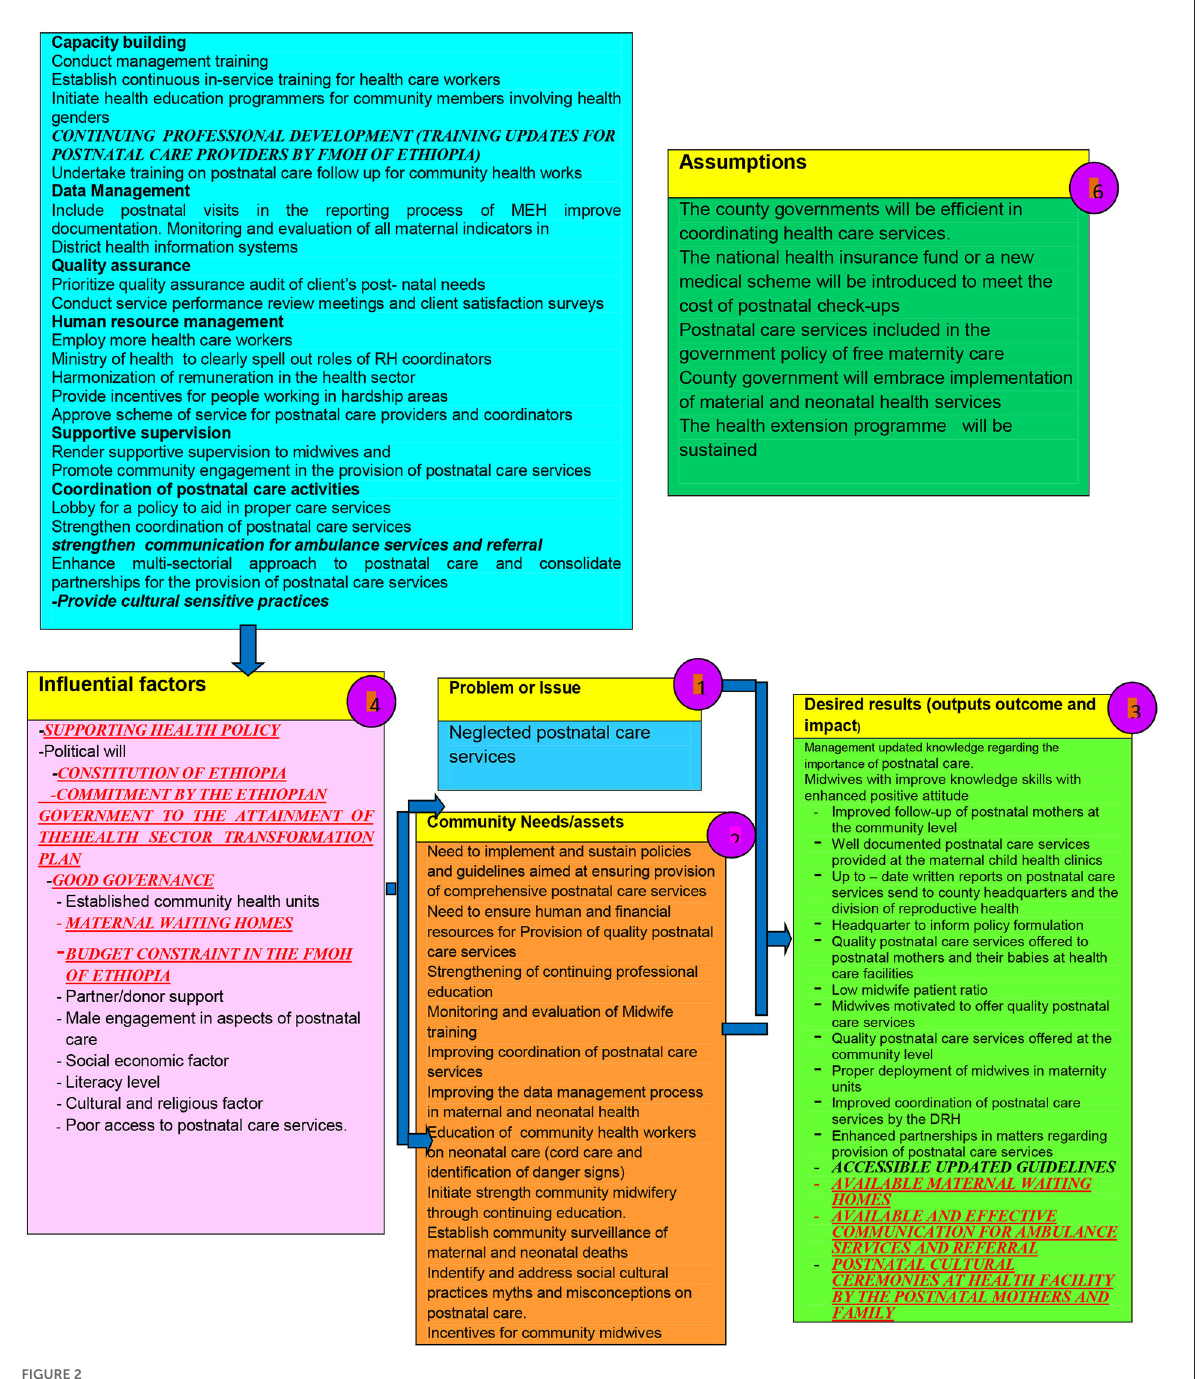
FIGURE2 The contextualized